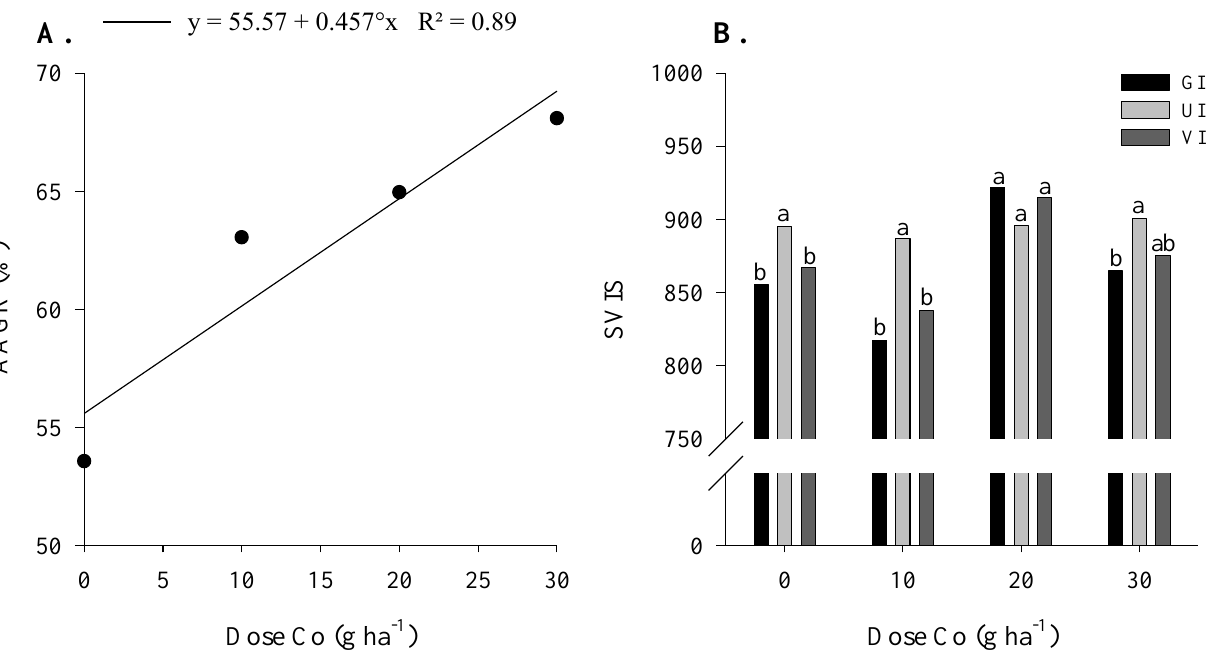
Figure 2. Accelerated aging germination rate (AAGR) ( A ), growth index (GI), growth uniformity index (UI), and vigor index (VI) ( B ) of soybean seeds as a function of foliar Co and Mo doses, applied to parent plants foliarly, in the maturation phase, under field conditions. °-Significant by t test ( p < 0.10). Bars followed by the same letter do not differ by Tukey test ( p < 0.05). There was no difference between the control and Co and Mo doses for the growth index (GI) (Table 3). However, the application of 20/800 g ha −1 of Co and Mo provided a